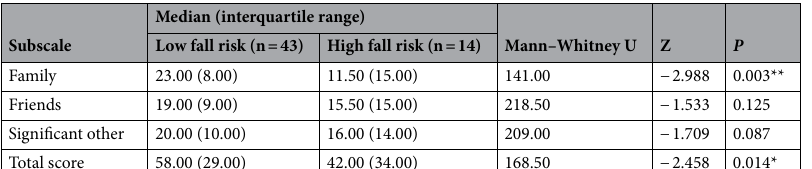
Median (interquartile